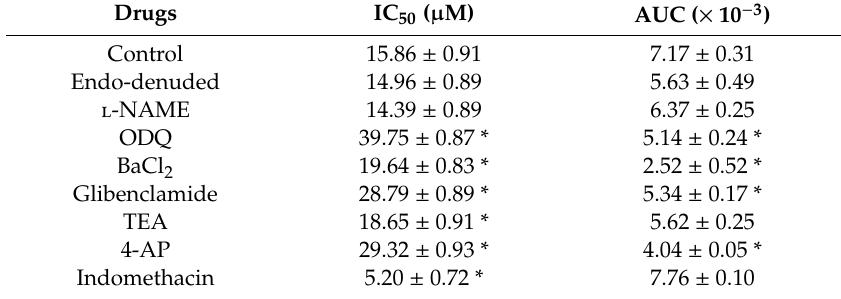
IC 50 and AUC represent the half maximal inhibitory concentration and area under curve, respectively. The values are mean ± standard error of the mean (S.E.M.) and represents the mean of at 6 independent experiments. Statistically significant difference * p < 0.05 vs. Control.